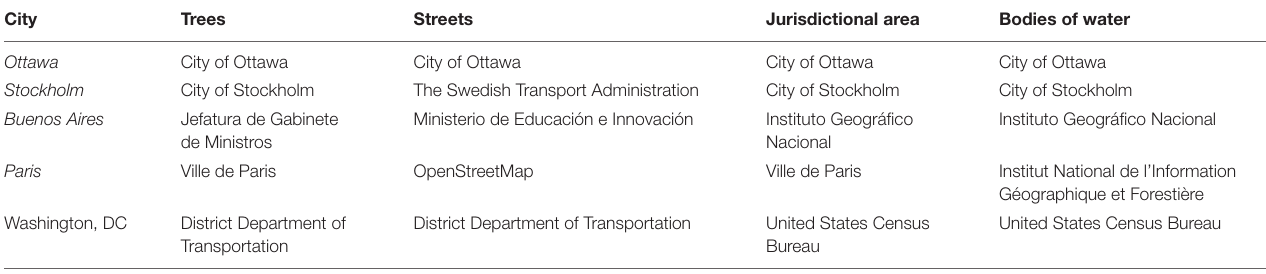
TABLE 1 | Sources of spatial data for the five cities.